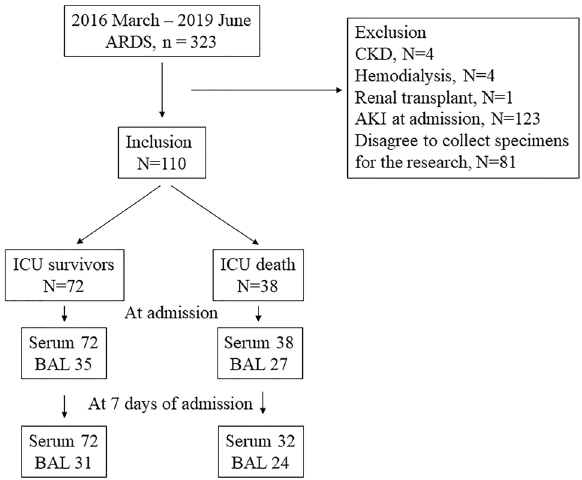
Figure 1. Flowchart of patient inclusion. During the study period, 323 patients were treated for acute respiratory distress syndrome, of which 110 were included in this study. ARDS acute respiratory distress syndrome, CKD chronic kidney disease, AKI acute kidney injury, ICU intensive care unit, BAL bronchial alveolar